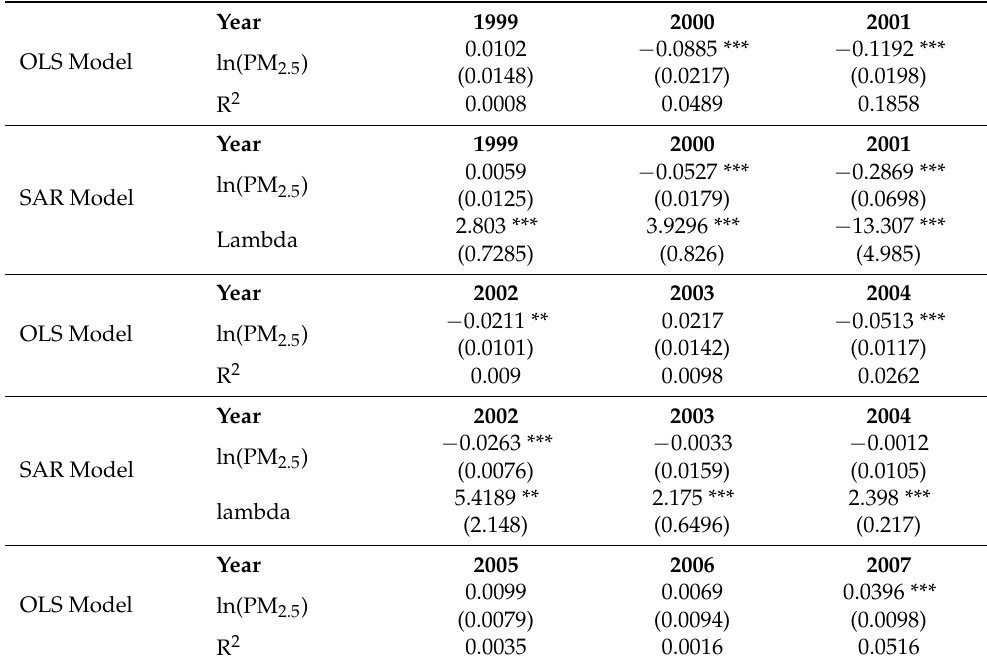
Table 2. Temporal convergence of PM 2.5 concentrations in each